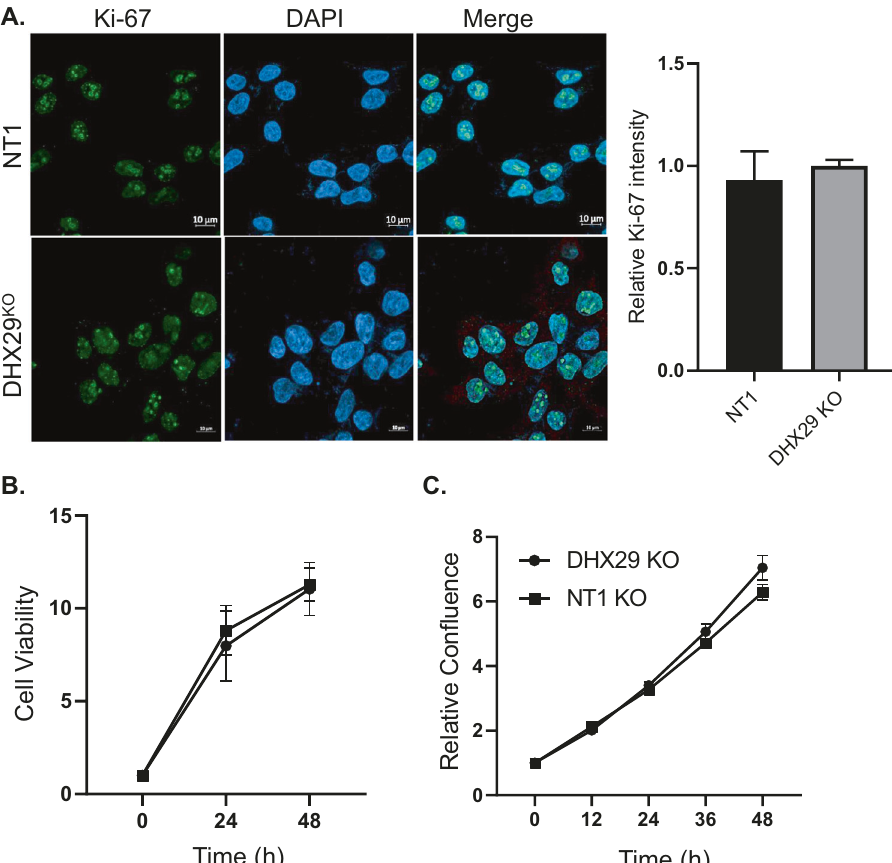
Fig. 3 DHX29 KO does not affect cell proliferation. A NT1 and DHX29 knockout cells were fi xed, permeabilized, and stained with an anti-Ki- 67 antibody. Cell nuclei were counterstained with DAPI. Bar = 10 µm. Ki-67 staining intensity was determined by ImageJ software measuring 3 fi elds of 15 – 20 cells in each fi eld. Results are mean values ± SD from 3 measurements. Unpaired t-test, nonsigni fi cant. B HEK293-DHX29 KO and NT1 control cells were seeded in equal amounts in a 96-well plate. Cell viability was measured by adding PrestoBlue reagent and measuring absorbance according to manufacturer instructions at 24 and 48 h. (B). Alternatively, cell con fl uence was measured every 12 h for 2 days using IncuCyte S3 Live-Cell analysis system. Results are mean values ± SD from 3 – 4 repeats. Two-tailed paired t -test, nonsigni fi